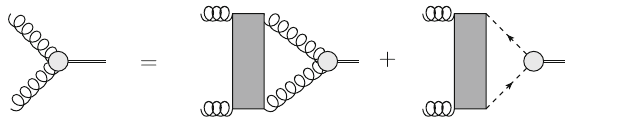
tors. The gray boxes represent interaction kernels given in Fig. 2. The Bethe–Salpeter amplitudes of the glueball are denoted by gray disks